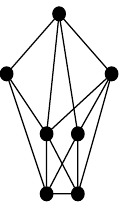
Figure 1. The generator